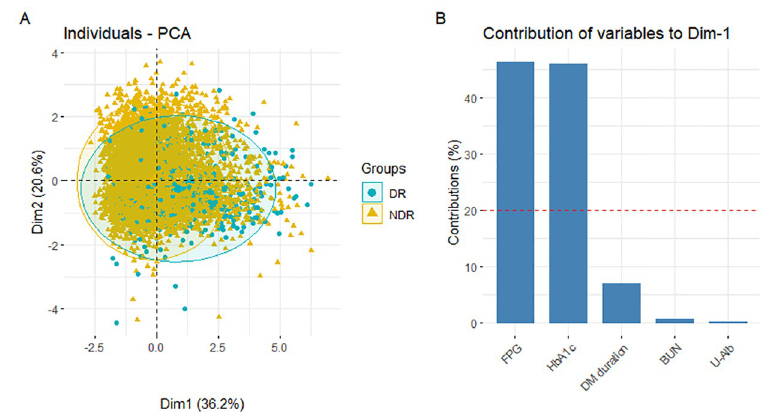
Fig 1. The results of principal component analysis (PCA). (A) The two-dimensional PCA results are based on the first and second principal components. (B) Contributions of variables to the first principal component. Abbreviations: DR, diabetic retinopathy; NDR, no diabetic retinopathy; FPG, fasting plasma glucose; HbA1c, glycated hemoglobin A1c; DM, diabetes mellitus; BUN, blood urea nitrogen; U-Alb, urinary albumin.